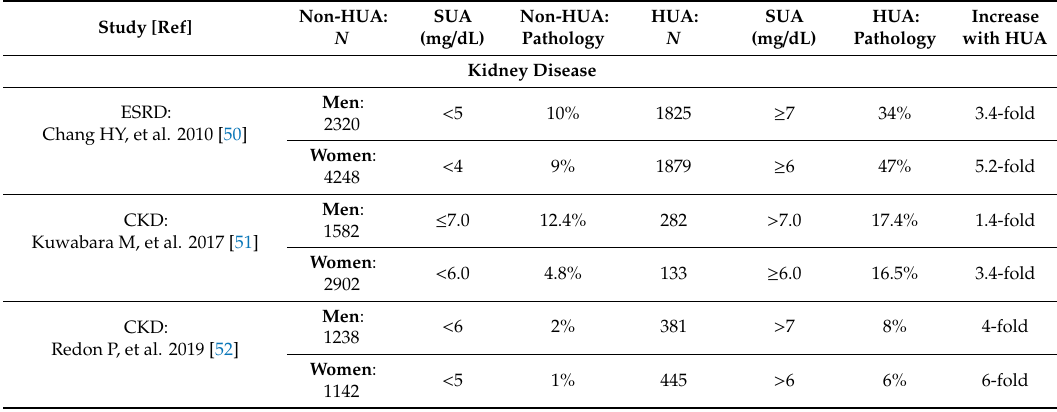
Table 1. Sex di ff erences in HUA associated